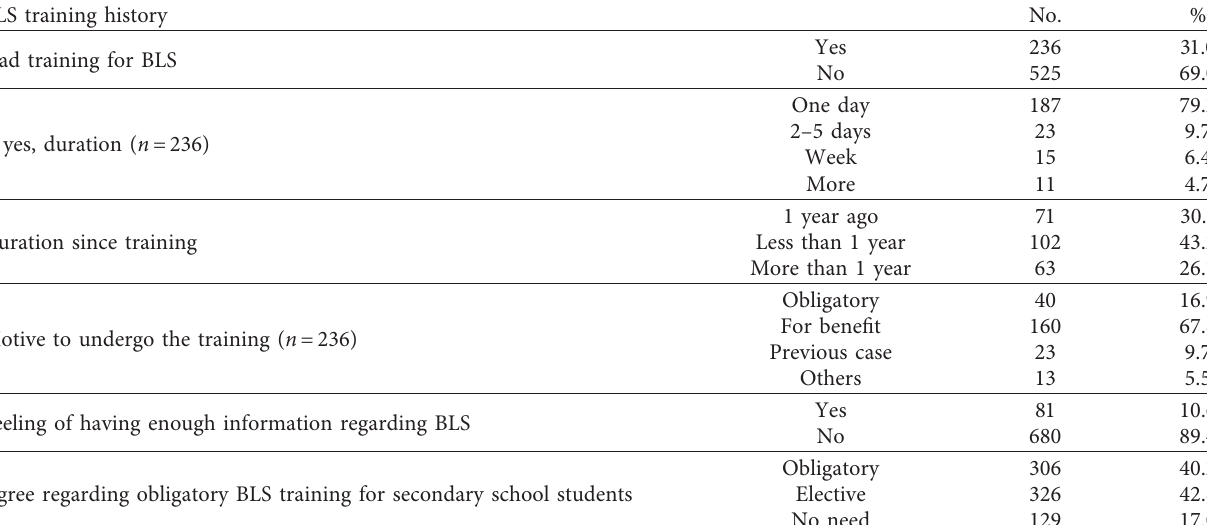
Table 2: BLS training history among secondary school students in Abha City, southern Saudi Arabia. BLS training